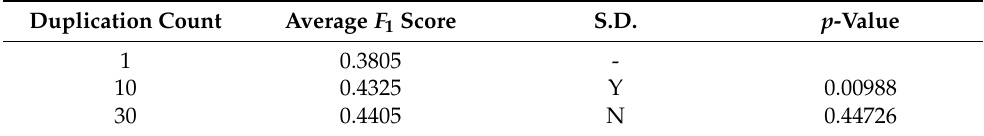
Table 1. Non-Matching Function Pair Duplication Test.